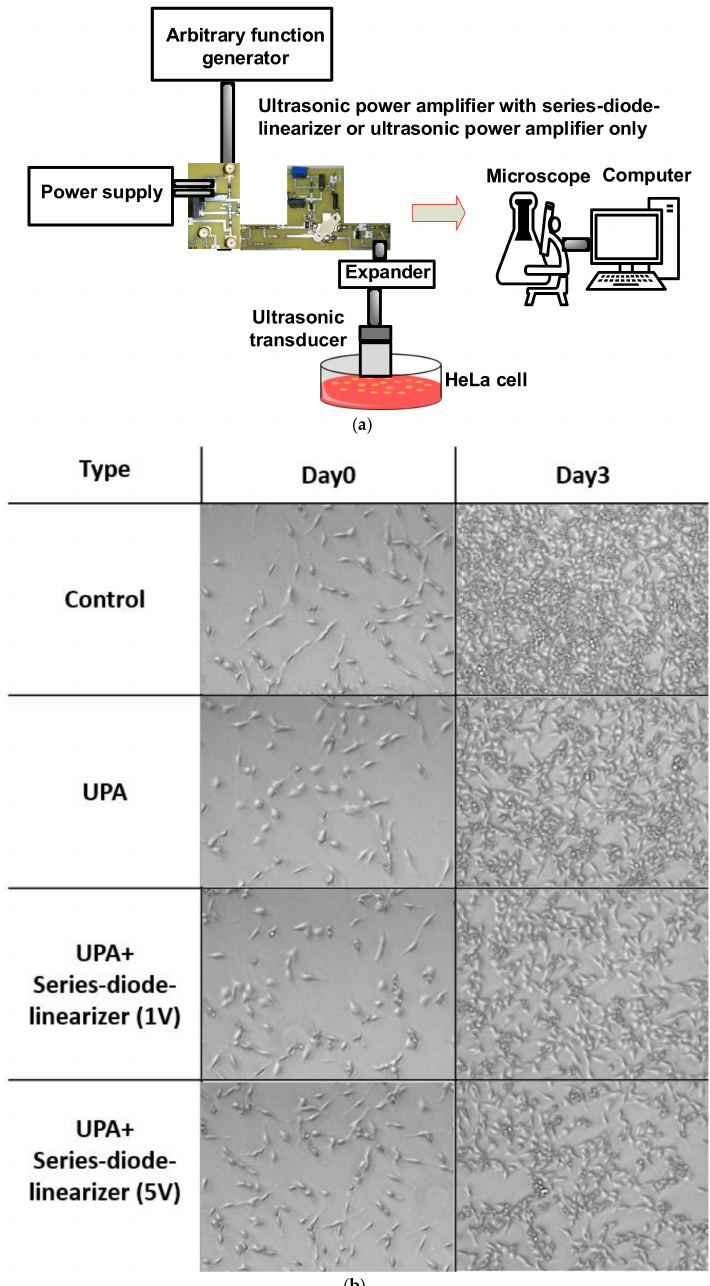
Figure 7. ( a ) HeLa cells experiment and ( b ) representative brightfield images from Day 0 to Day 3 acquired using a